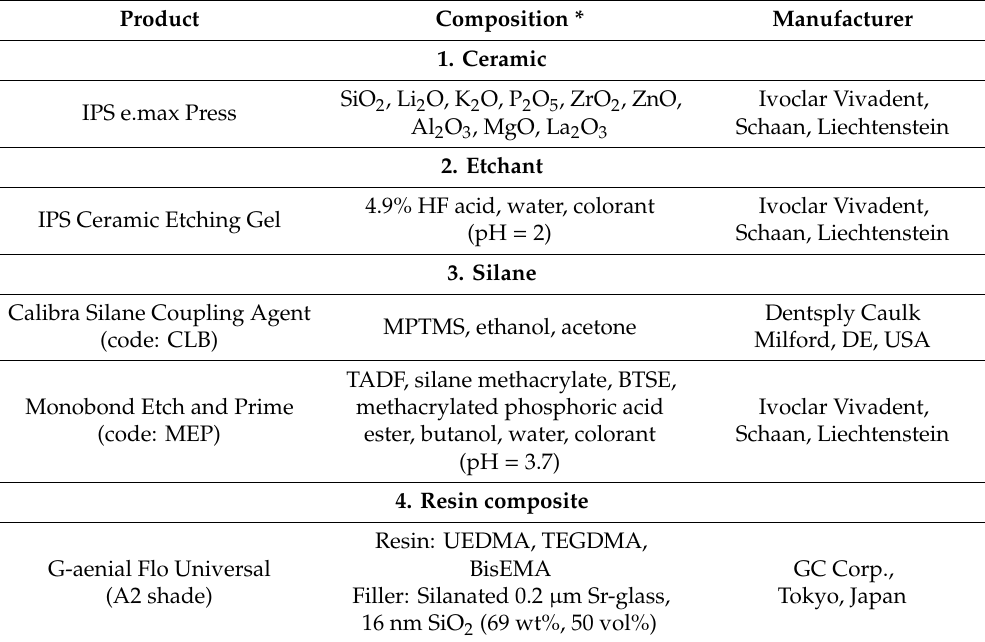
Table 1. The products used in the